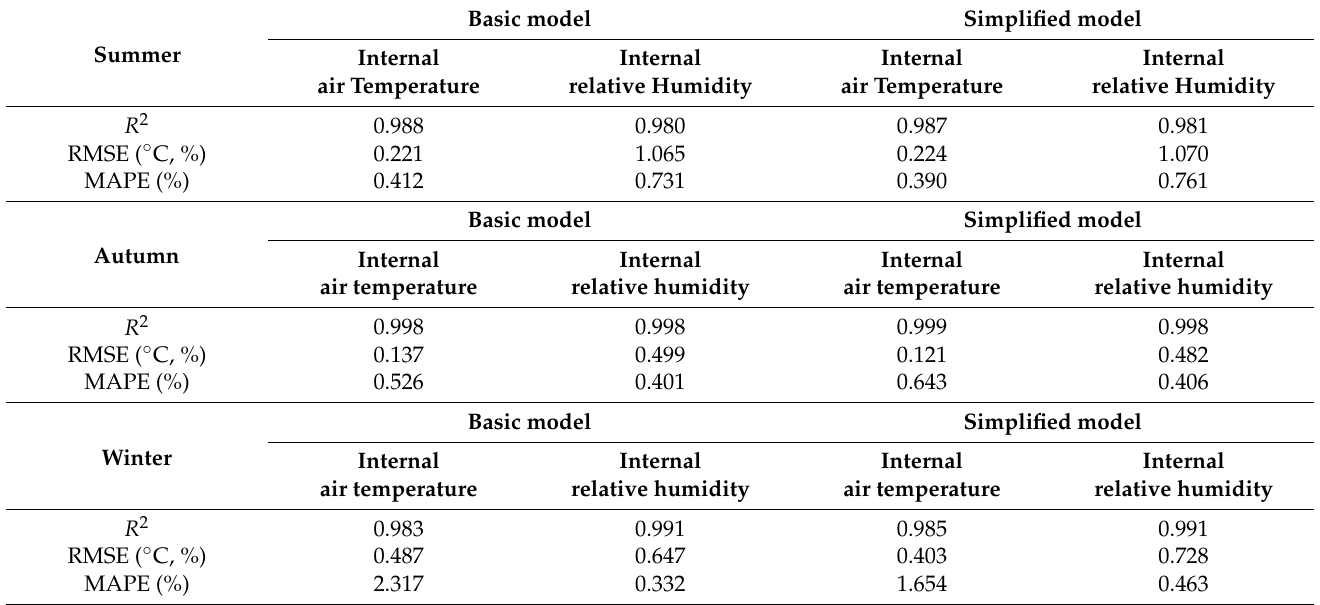
Table 8. Accuracy of RNN model of mechanically ventilated duck house according to seasons and variables (reverse order).